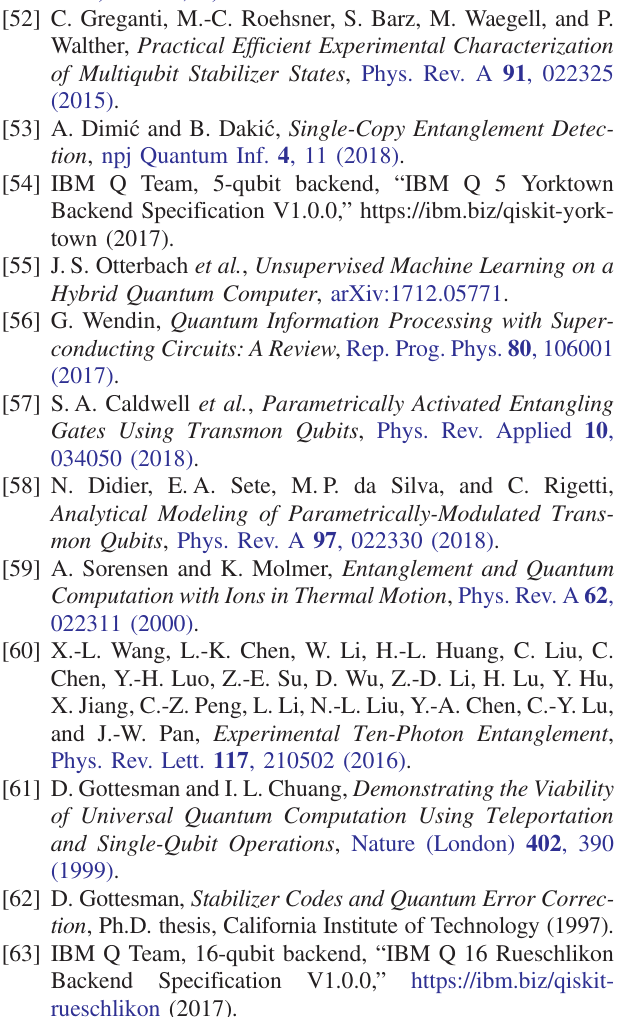
Algorithmic Benchmark for Quantum Information Process- ing , Nature (London) 404 , 368